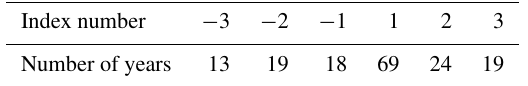
Table 3. Droughts in Sweden 1500–1800CE. The number of years that have been labeled anything but “normal” is